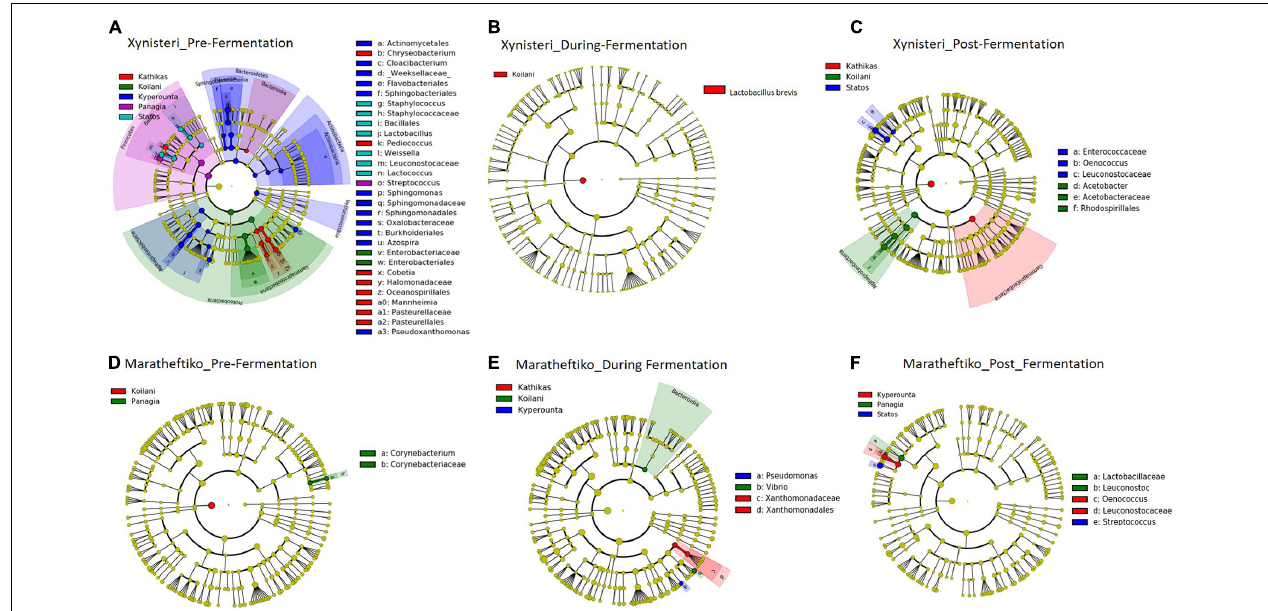
FIGURE 9 | LEfSe analyses of taxon abundances of over-represented bacterial taxa among grape wine varieties and among stages of fermentation. (A) Variety Xynisteri pre-fermentation; (B) variety Xynisteri during fermentation; (C) variety Xynisteri post-fermentation; (D) variety Maratheftiko pre-fermentation; (E) variety Maratheftiko during fermentation; (F) variety Maratheftiko